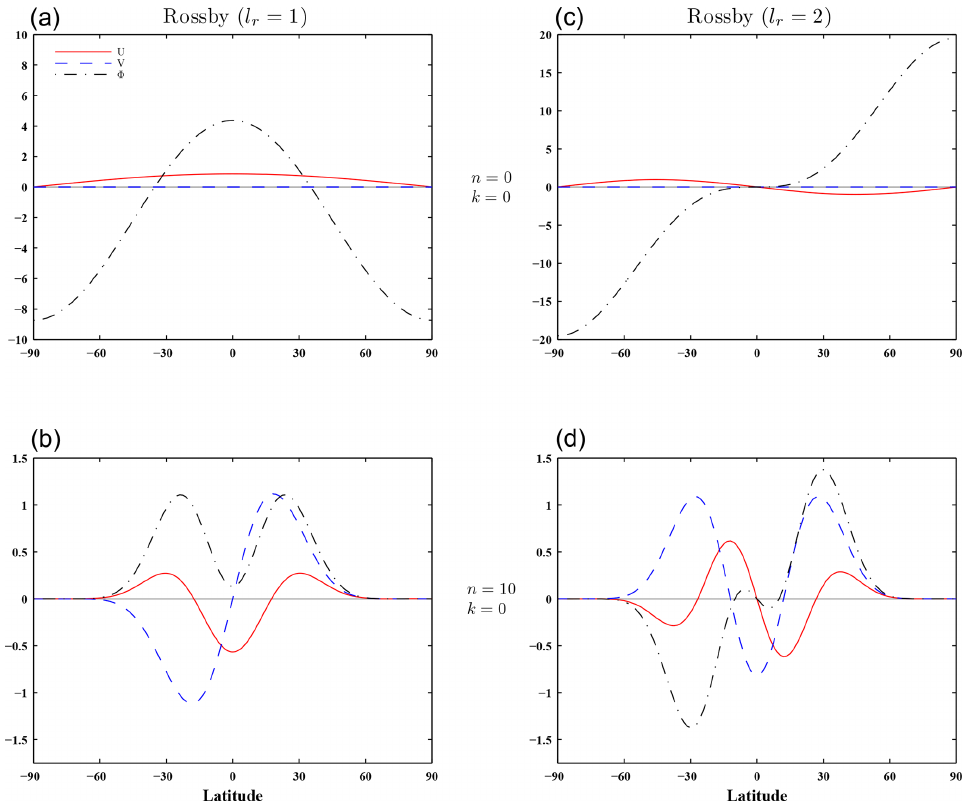
Figure 8. The same as in Fig. 6 but for the Haurwitz modes ( h 0 = ∞